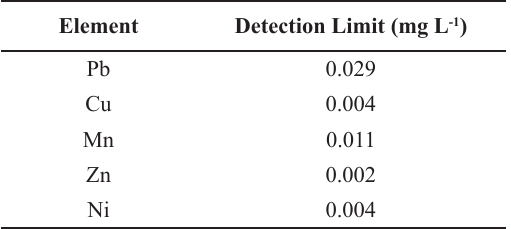
Table 1: Detection limits of the heavy metals in AAS. Element